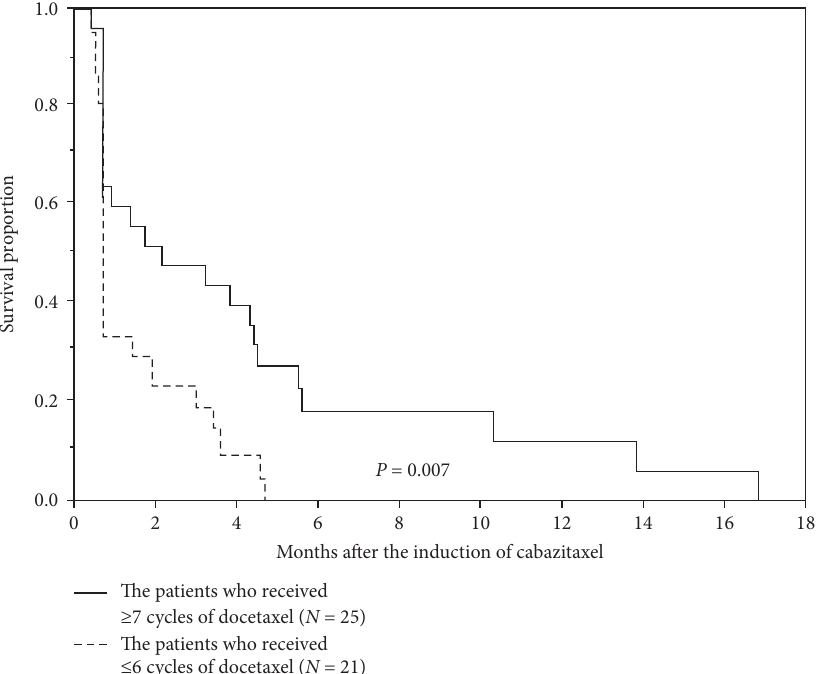
Figure 4: Kaplan–Meier estimate of progression-free survival (PFS) after the administration of cabazitaxel (CBZ). The median PFS in patients with prostate cancer who received ≥ 7 cycles of docetaxel (DOC) followed by CBZ was significantly longer than that in patients who received ≤ 6 cycles of DOC followed by CBZ ( P < 0 . 007 )